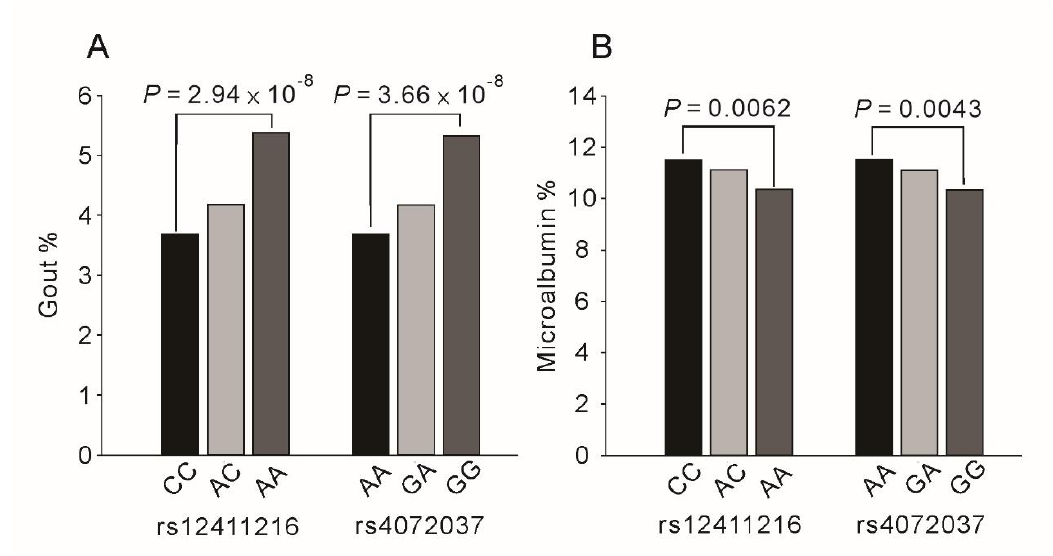
Figure 1. Association between MUC1 rs12411216 and rs4072037 genotypes for gout ( A ) and microalbuminuria ( B ). p values were adjusted for age, sex, body mass index, and current smoking. Significantly higher frequencies of gout and lower frequencies of microalbuminuria were noted for A allele of rs407203 and C allele of rs12411216.